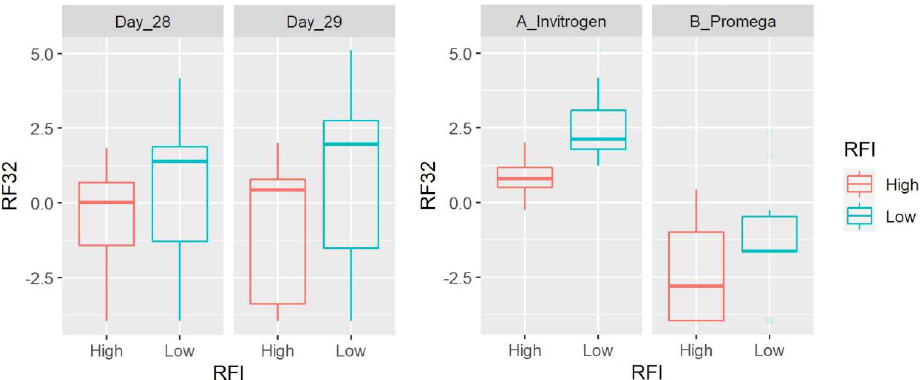
on clr-transformed data. Data are shown for both day of sampling and DNA extraction method. There was a significant difference between LRFI and HRFI ( p = 0.0059) and DNA extraction methods ( p = 0.0020), with no time effect.